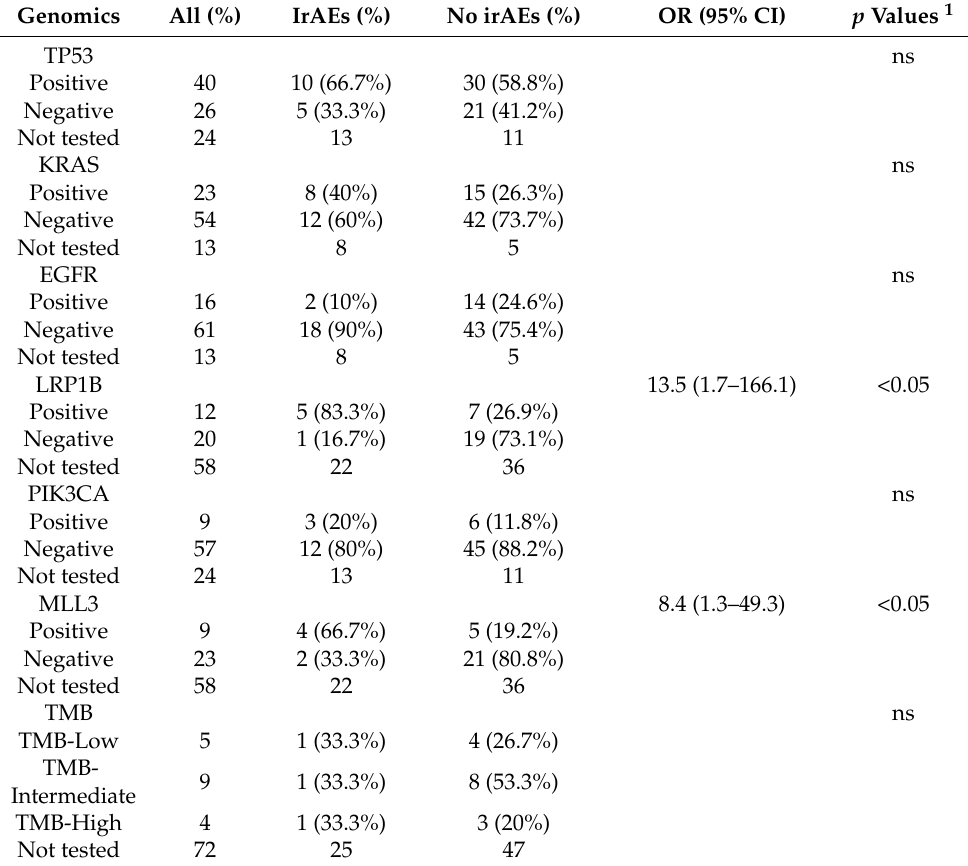
Table 4. Mutations and their associations with irAEs.